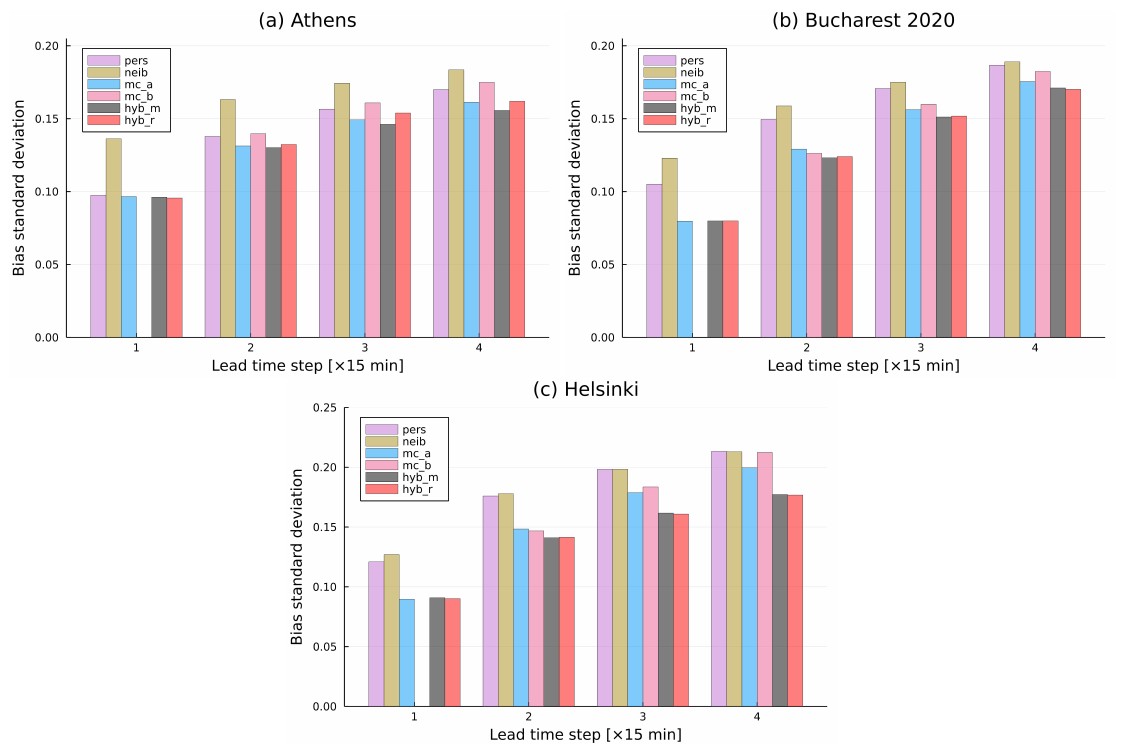
Figure A2. Standard deviation of cloud modification factor (CMF) prediction bias for ( a ) Athens, ( b ) Bucharest, and ( c )